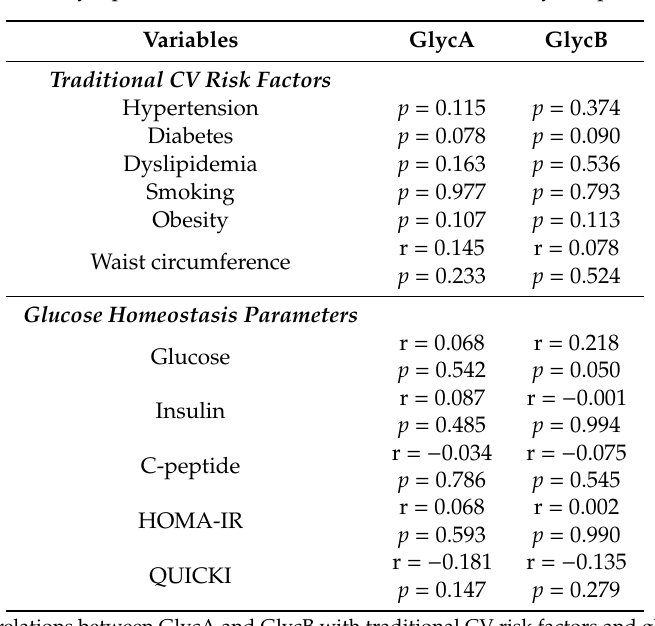
r = 0.145 r = 0.078 p = 0.233 p = 0.524 r = 0.068 r = 0.218 p = 0.542 p = 0.050 r = 0.087 r = − 0.001 p = 0.485 p = 0.994 r = − 0.034 r = − 0.075 p = 0.786 p = 0.545 r = 0.068 r = 0.002 p = 0.593 p = 0.990 r = − 0.181 r = − 0.135 p = 0.147 p =